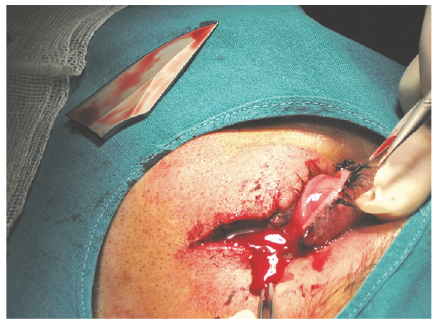
Figure 3: Disinsertion of the lower eyelid. The foreign body turned out to be a fragment of a dagger.